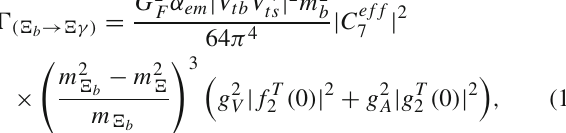
Table 2 The values of physical constants, elements of CKM matrix and baryon lifetimes [42] Constant Value